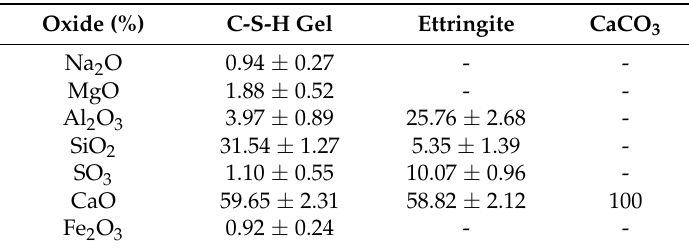
Figure 6. Morphology of compounds in 4 days carbonated OPC paste. Table 5. EDX chemical analysis of the hydrated phases.